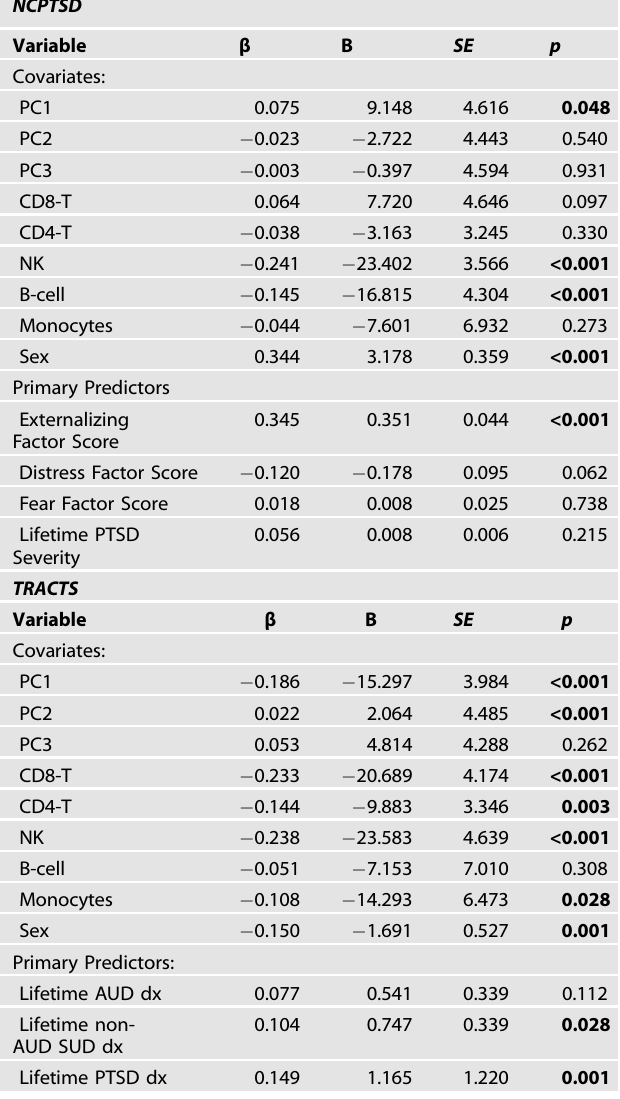
Table 2. Psychopathology as a predictor of GrimAge residuals in both